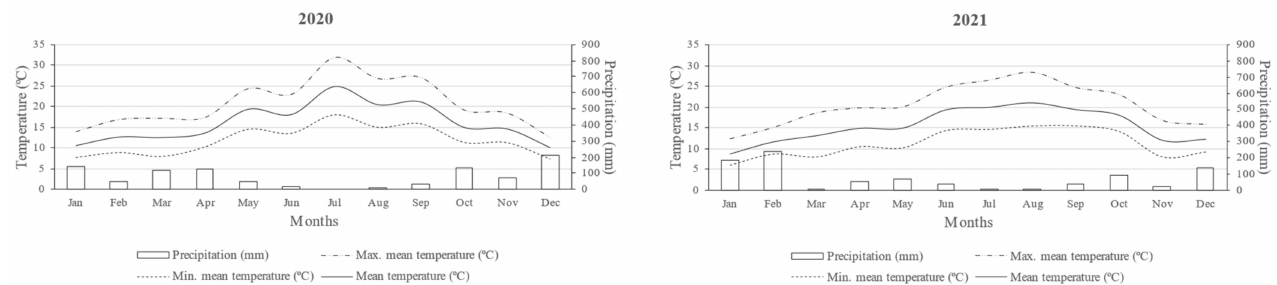
Figure 7. Distribution of climatic parameters for the years 2020–2021.